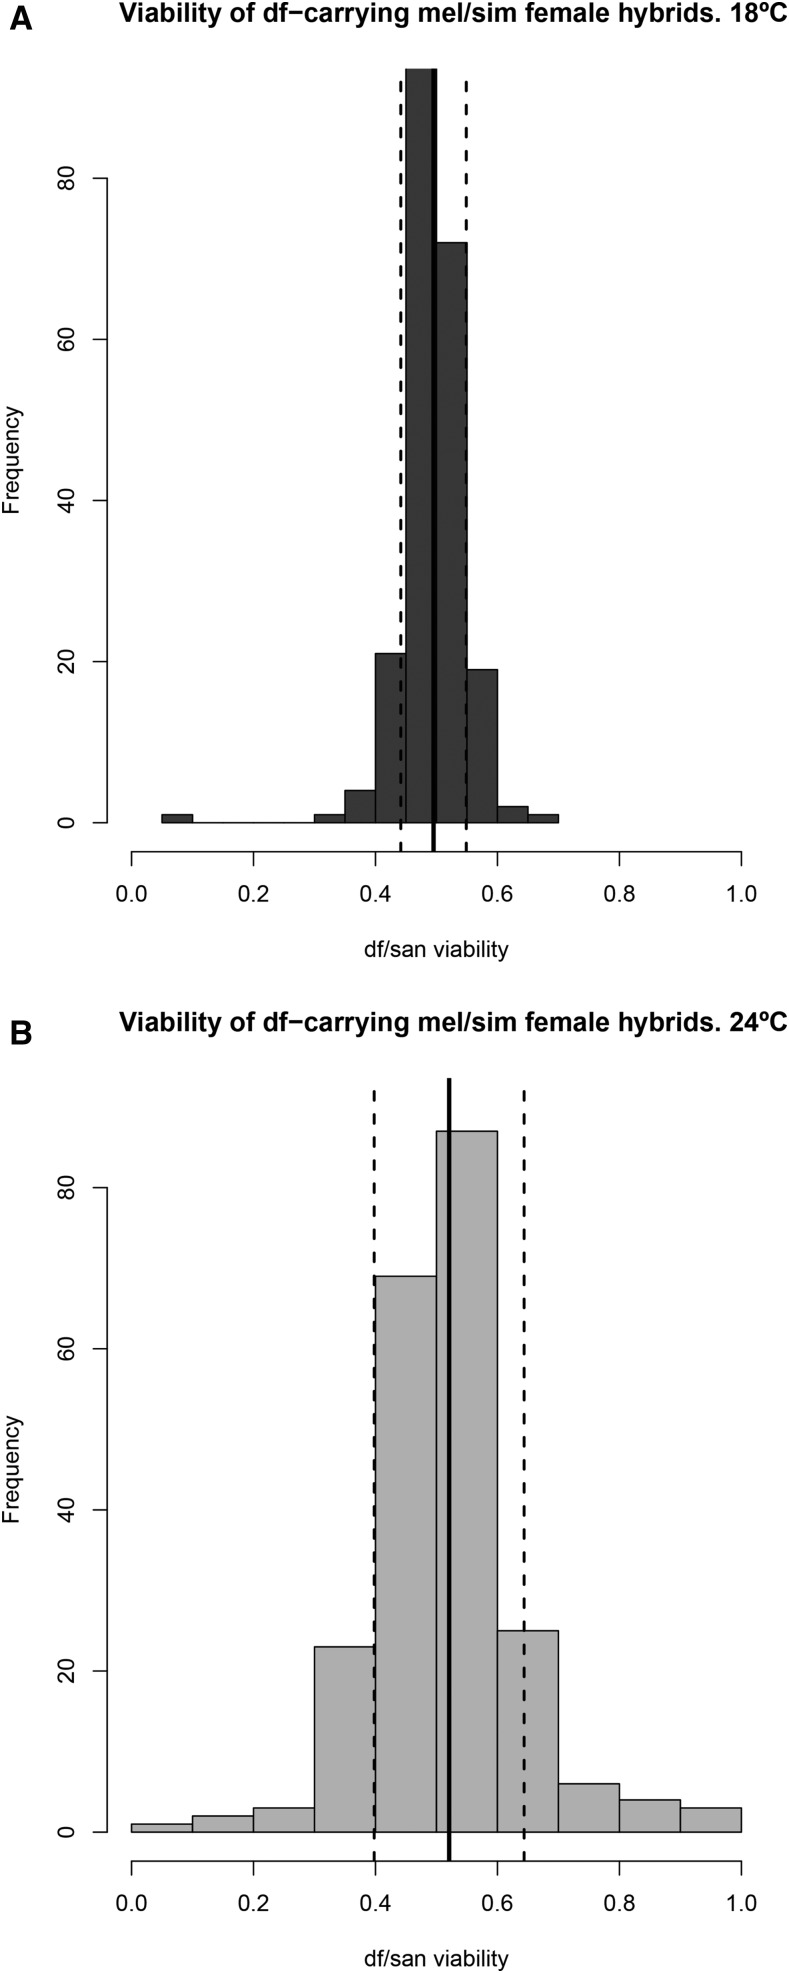
Fitness frequencies of the df-carrying hybrids in mel/sim hybrids at two different temperatures. (A) mel/sim 18°. (B) mel/sim 24°. Black solid lines in each panel show the mean fitness of the df-carrying hybrids. Black dashed lines show the average ± SD from the mean. The x-axis shows relative viability of deficiency-carrying progeny (observed df-carrying progeny/observed Bal-carrying progeny + observed df-carrying progeny) while the y-axis shows the number of stocks having a given level of viability of deficiency carrying offspring. Bal, balancer chromosome; df, deficiencies; mel, D. melanogaster; sim, D. simulans.